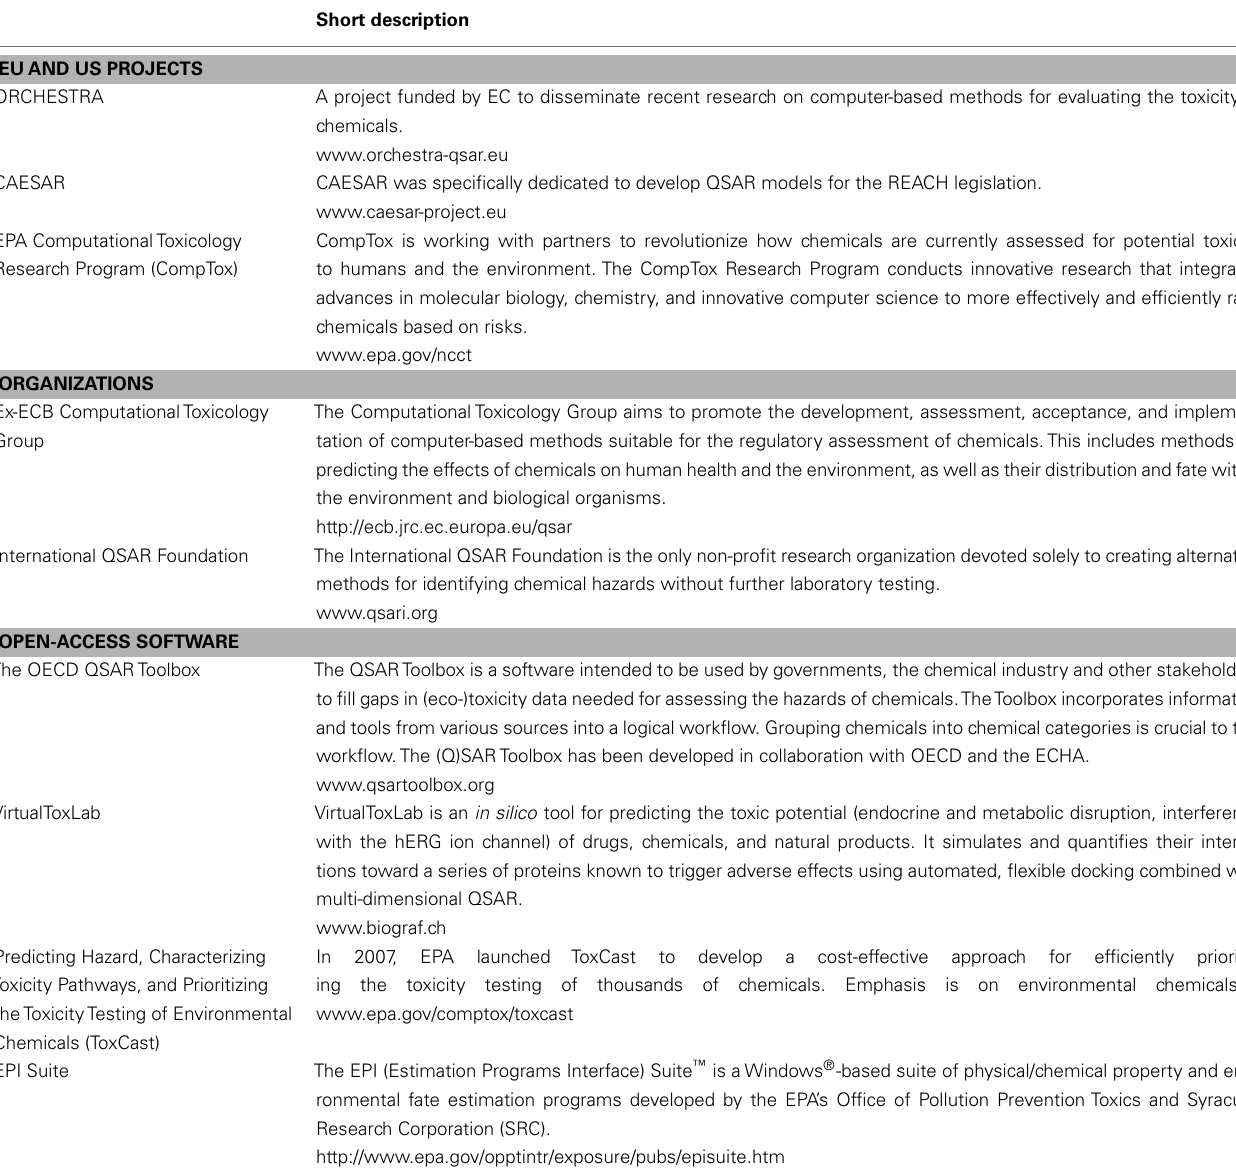
Table 1 | Examples of in silico toxicology projects and